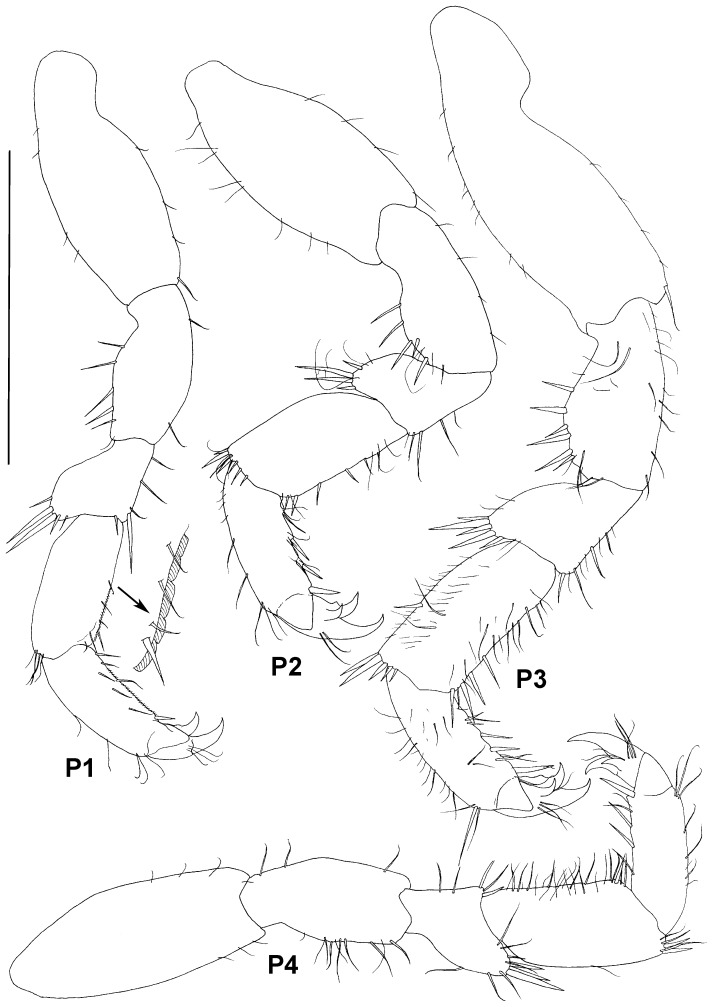
Paratype ZMH K-44090, male, pereopods 1–4, scale – 0.5 mm.